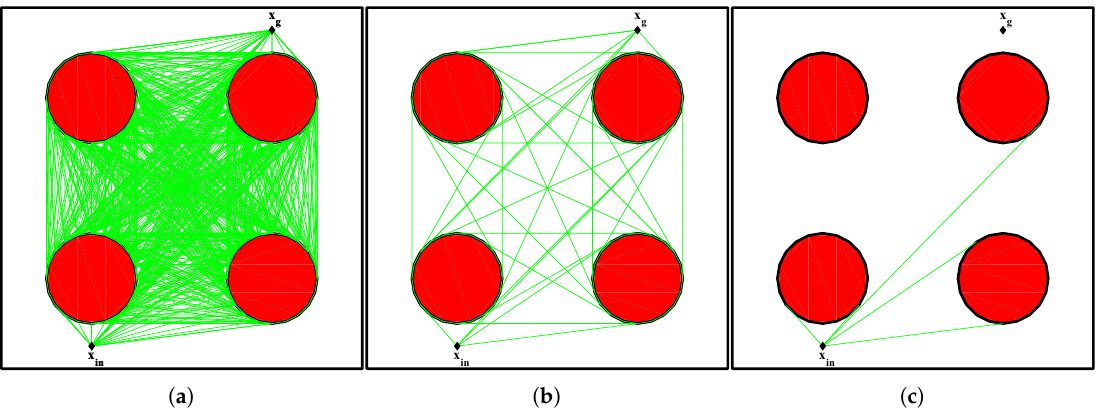
Figure 6. ( a ) Unreduced; ( b ) reduced complete; and ( c ) reduced partial VG . The initial state x in and goal state x g are depicted by black